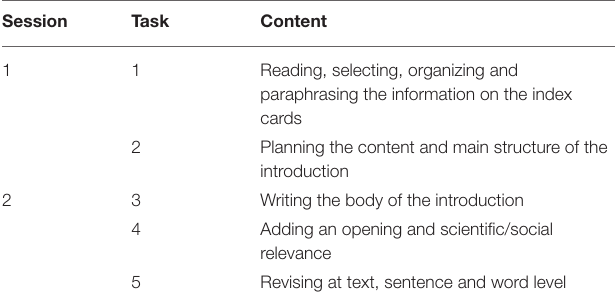
TABLE 3 | Summary of the tasks used in the observational learning videos and learning-by-doing exercises.